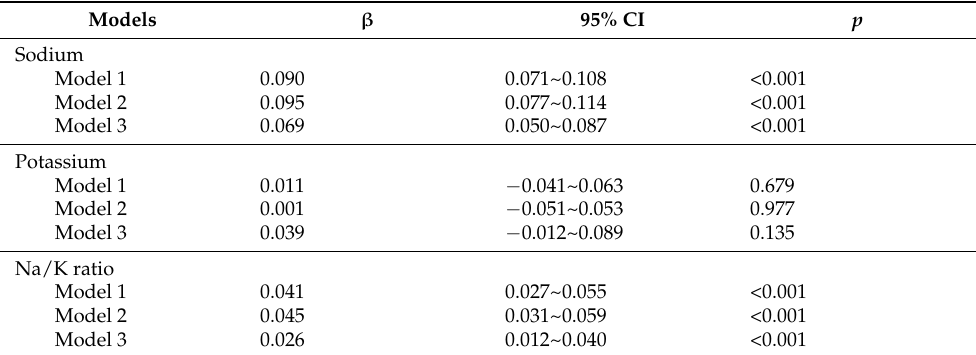
Table 2. Association of urinary index (g/d) and natural log transformed albumin excretion rate (mg/d) using the mixed linear effect